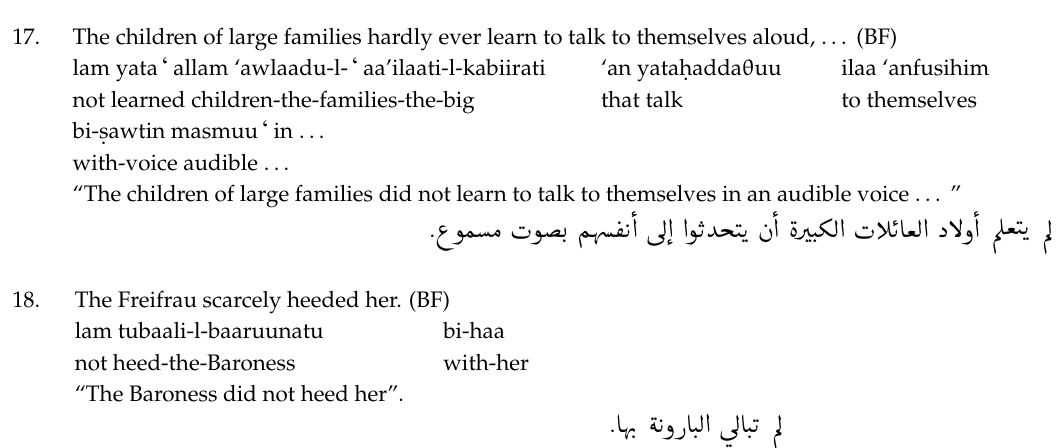
Table 4. Frequency and percentage of translation strategies in rendering -ly negation.